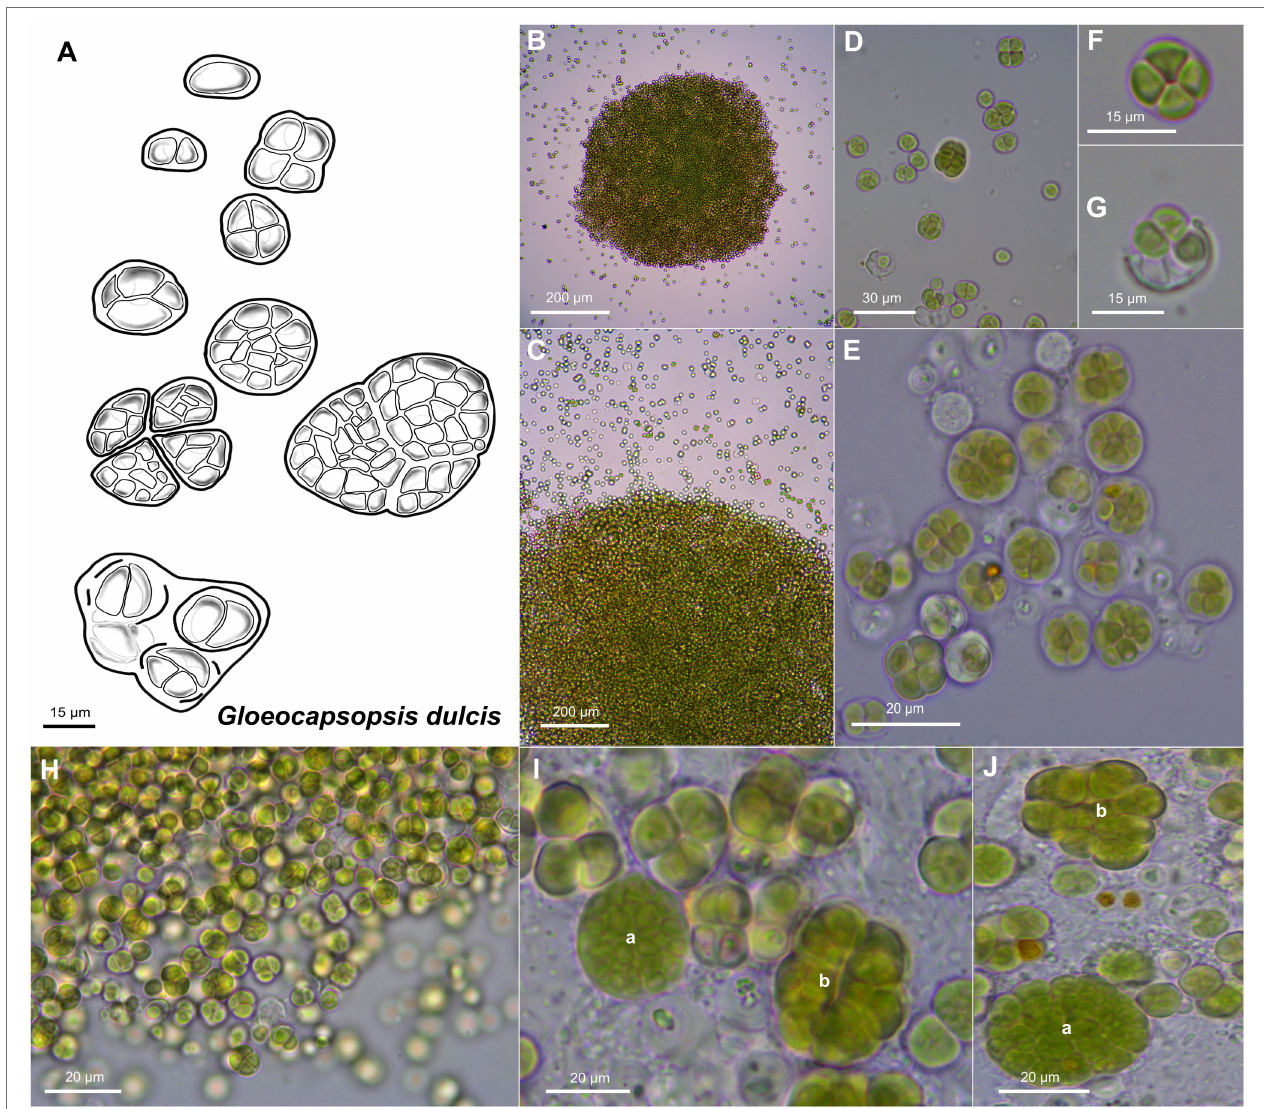
FIGURE 4 | Morphological characteristics of G. dulcis sp. nov. strain AAB1. (A) Scheme summarizing the life cycle of G. dulcis . (B,C) show microcolonies releasing single cells and small cell aggregates. (D,E) depict various types of aggregates. (F) shows a tetrad of cells. (G) shows single cells been released from a previously shared sheath. (H) depicts the aspect of a young culture. (I,J) show type a colonies made of densely packed cells surrounded by a firm sheath, and type b colonies made of cell packages surrounded by firm sheath mimicking the form of the